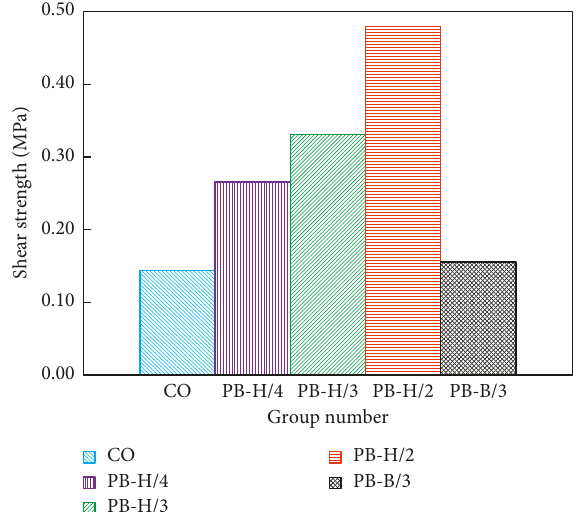
Figure 16: Comparison of shear strength of masonry triplets.